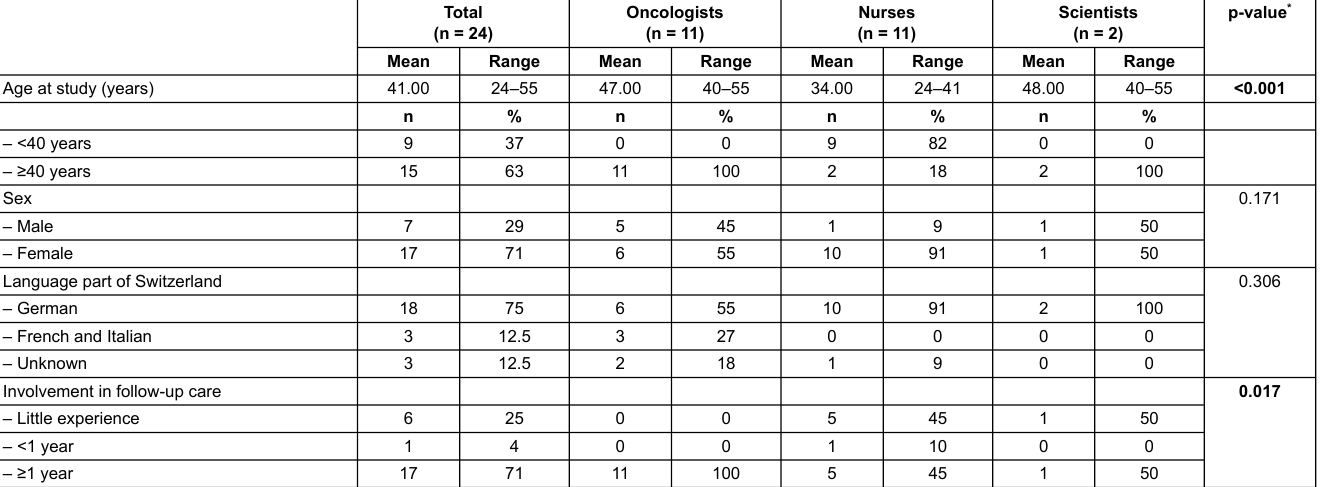
Table 1: Characteristics of participants working in follow-up care of childhood cancer survivors: by